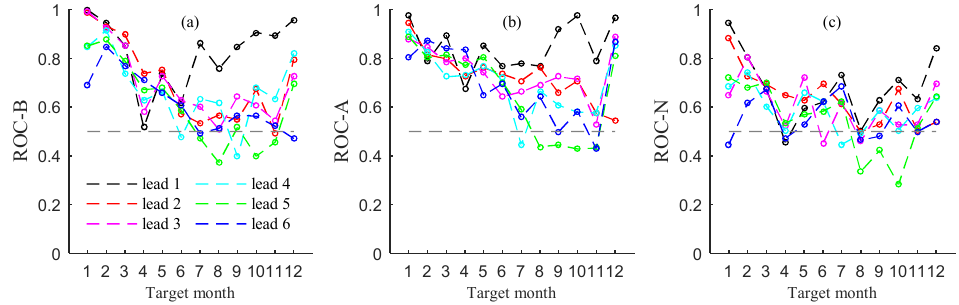
Figure 6. Variation of ROC areas for ( a ) below-normal, ( b ) above-normal, and ( c ) near-normal with the target month for six lead times for the Yangtze River.